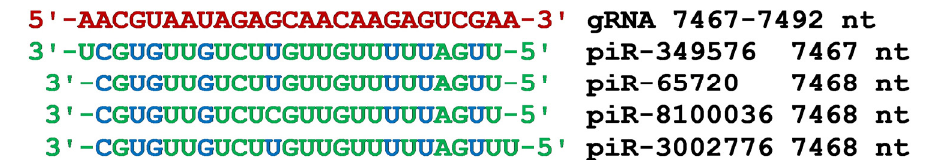
Figure 5. Nucleotide sequences of the piRNA BSs cluster in the CDS of gRNA from 7137 nt to 7161 nt and the nucleotide sequences of four piRNAs. Note: The piRNA nucleotides that form canonical pairs with gRNA are highlighted in green and non ‐ canonical pairs are highlighted in blue. The names of the piRNAs are followed by the beginning of their BSs.